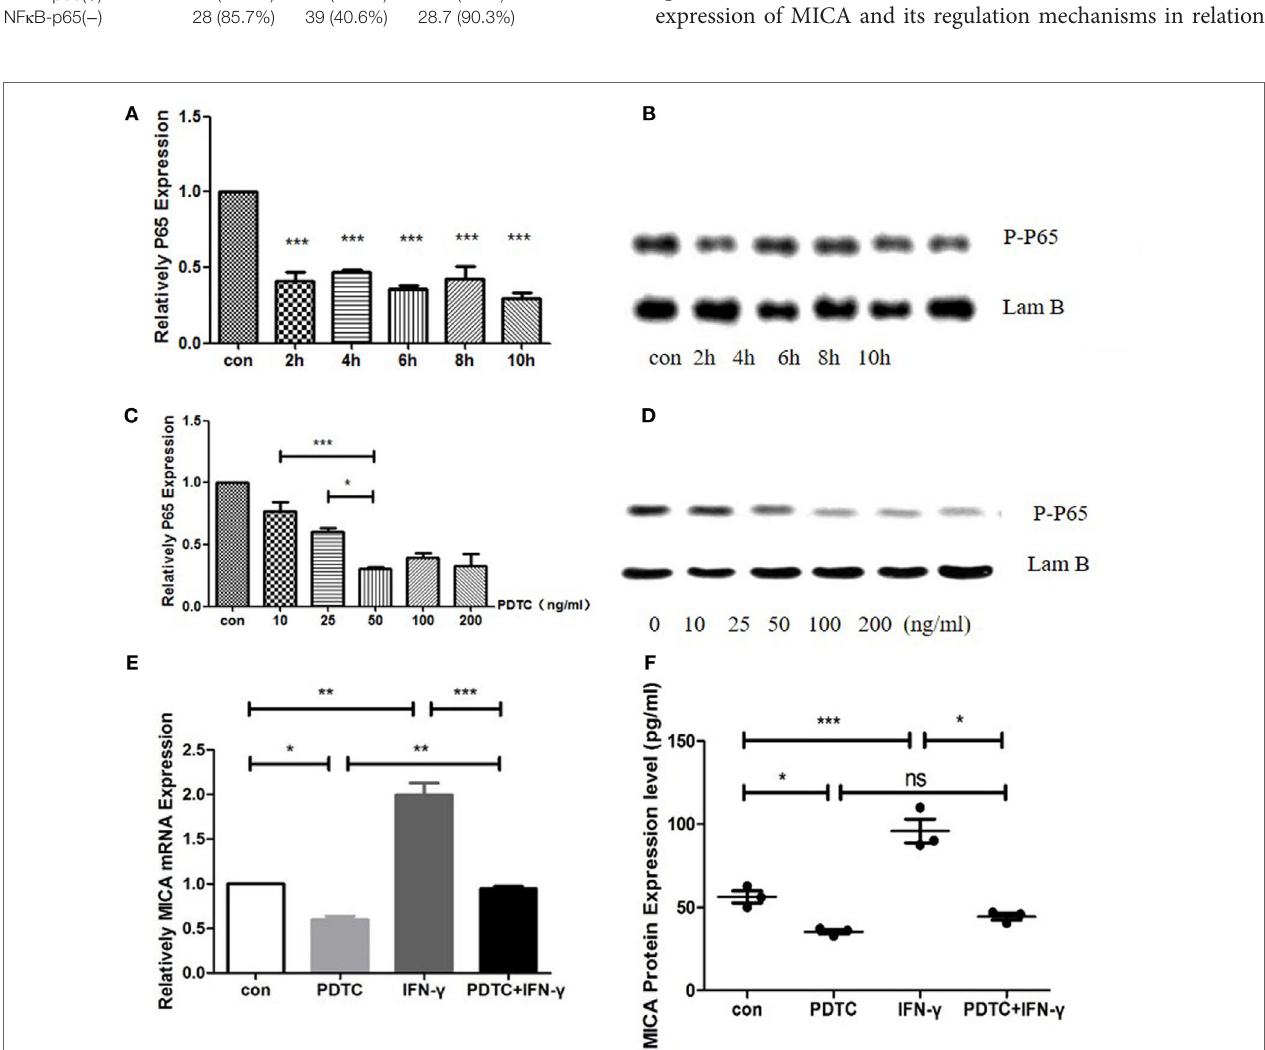
FigUre 6 | Inhibition of NF κ B by pyrrolidine dithiocarbamate (PDTC) decreased MICA expression levels. (a) RT-PCR analysis of the MICA mRNA levels (B) and enzyme-linked immunosorbent assay (ELISA) analysis of the MICA protein expression levels in cells treated with 100 ng/ml of PDTC. (c) The expression of MICA mRNA levels (D) and protein levels after PDTC treatment for 2 h. (e,F) PDTC decreased both MICA mRNA and protein expression levels in human corneal epithelial cells, as demonstrated by RT-qPCR and ELISA, respectively. IFN- γ treatment significantly upregulated the MICA mRNA expression levels compared to the PDTC group.* p < 0.05; ** p < 0.01; *** p <